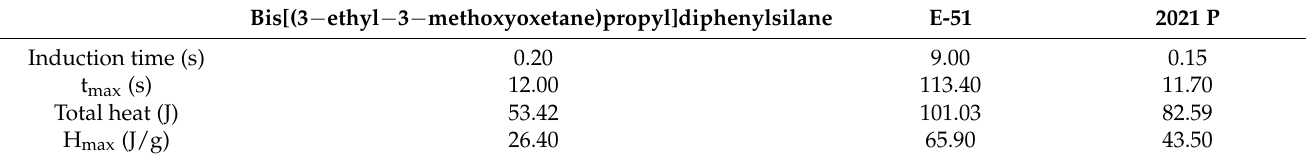
Table 4. Data of Photo-DSC.